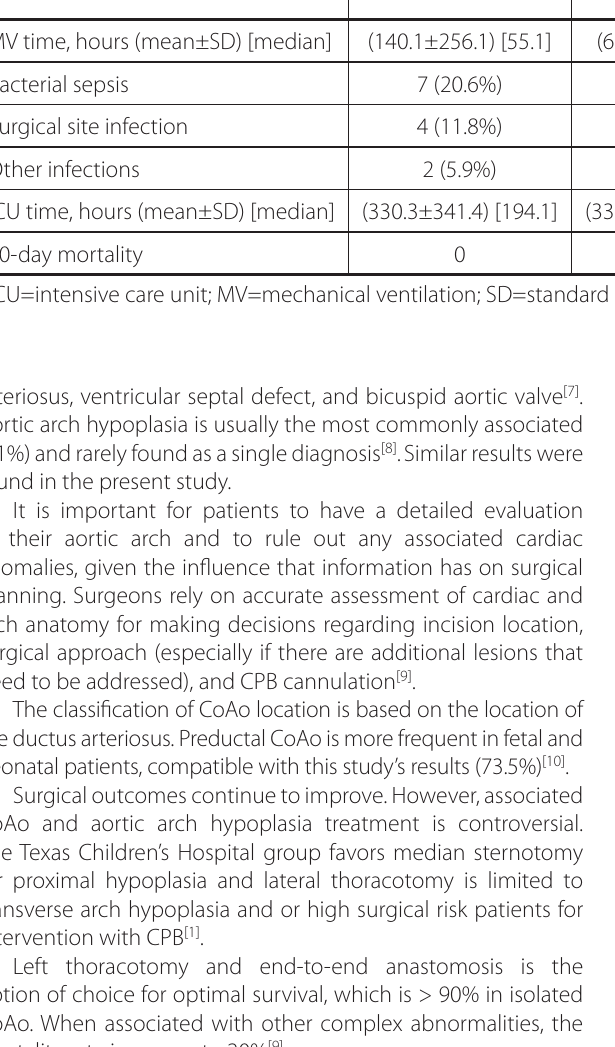
Table 6 . Postoperative and immediate mortality data post coarctation of the aorta repair. Postoperative